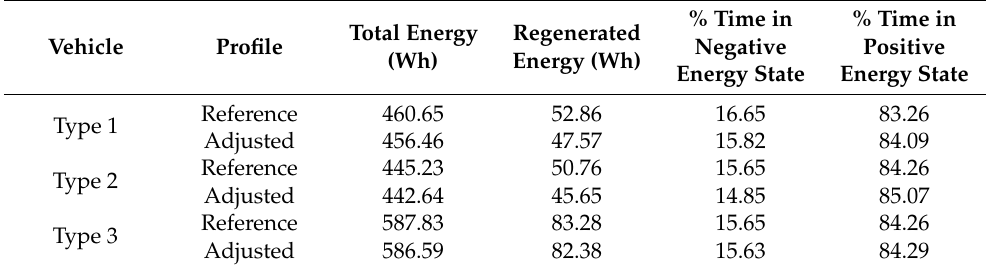
Table 6. Energy-related summary statistics of adjusted drive cycles (WMTC Cycle